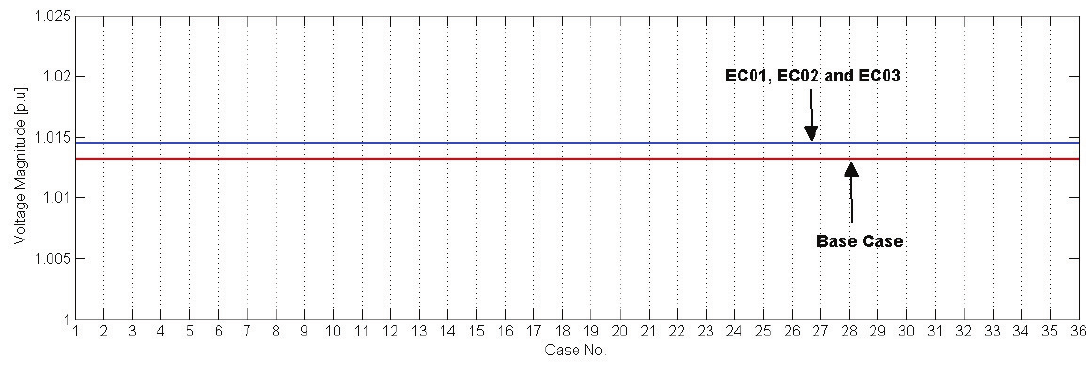
Figure 10. Voltage mode in FirstEnergy transmission system.